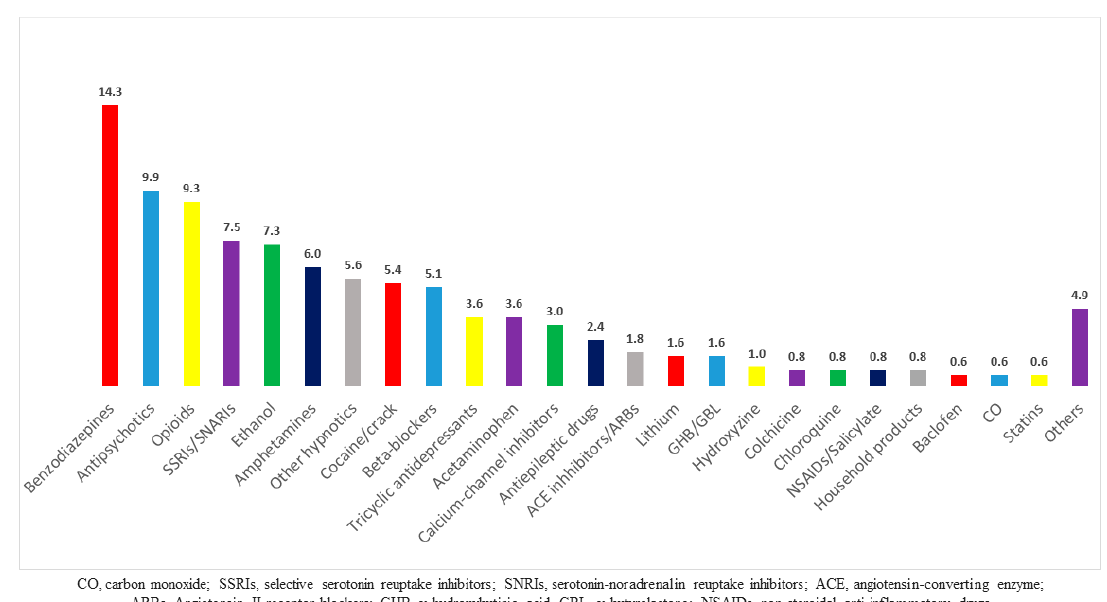
Figure 1. Toxicants involved in the poisonings with rhabdomyolysis based on the medical history (with their respective percentages noted above the bars).